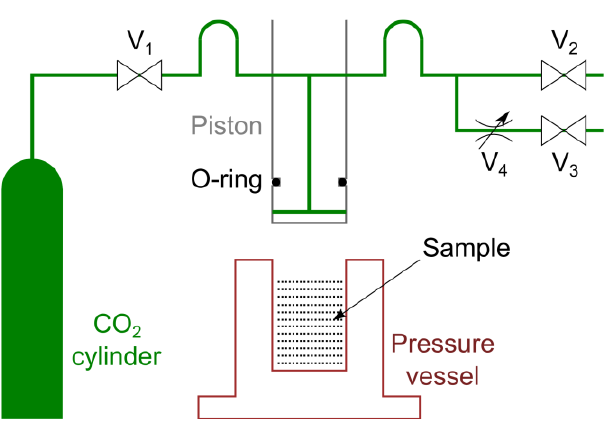
Figure 1. Schematic of the CO 2 -assisted polymer compression equipment. V 1 is the introduction valve; V 2 is the exhaustion valve for rapid exhaustion; V 3 is the exhaustion valve for slow exhaustion; and V 4 is the metering valve.